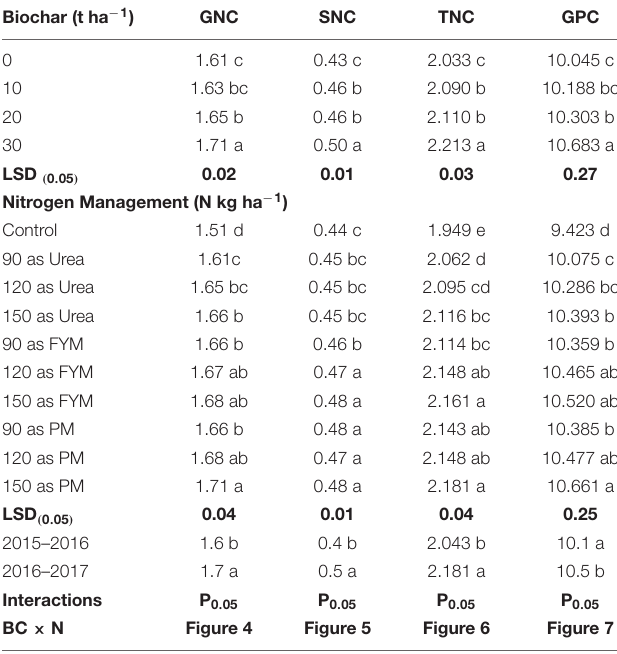
TABLE 2 | Nitrogen nutrition and grain protein content (%) of wheat as affected by biochar application under integrated N management. Biochar (t ha − 1